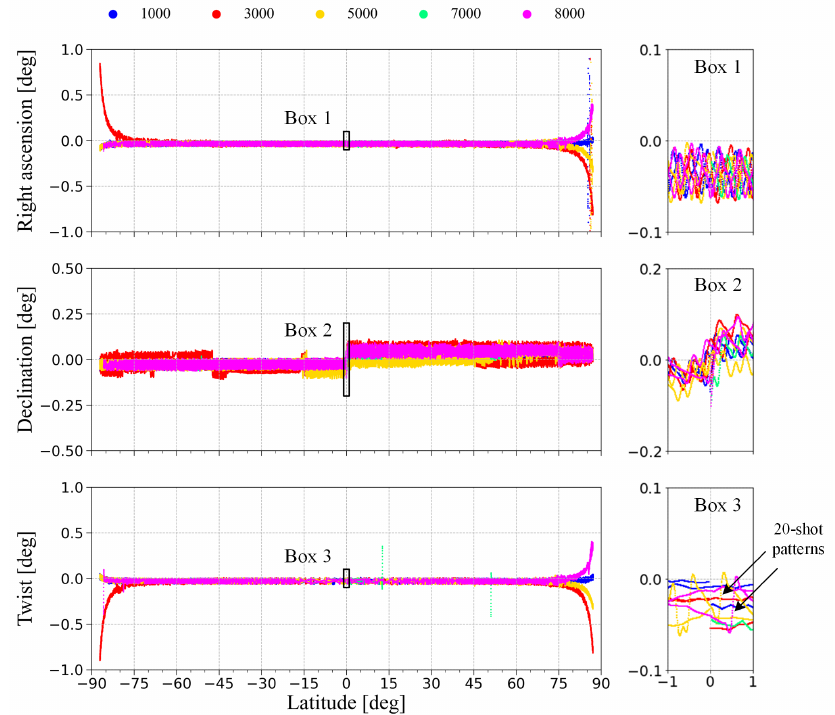
Figure 10. Comparison of the MGS orientation angles between the attitude information documented in the NAIF CK kernels and the PEDR dataset. Insets in the right column exhibit zoom-in views of these differences. Examples of 20-shot patterns are indicated by arrows.